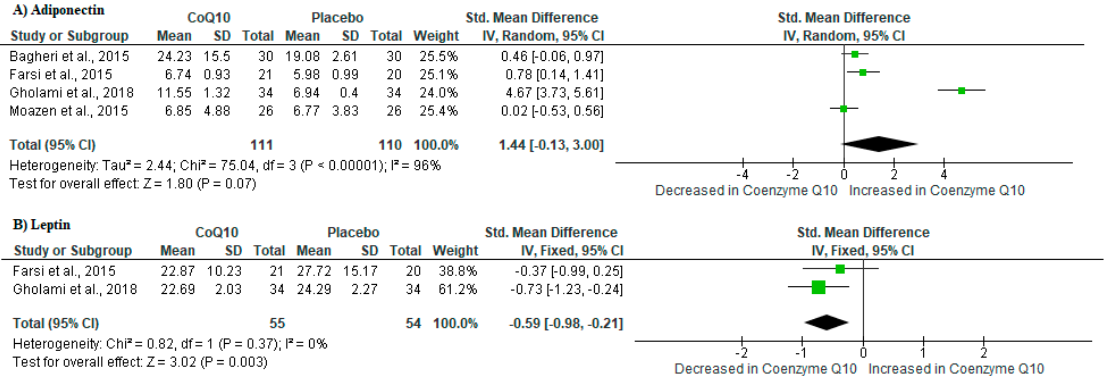
Figure 2. The impact of coenzyme Q 10 (CoQ 10 ) supplementation on adipokine levels in individuals